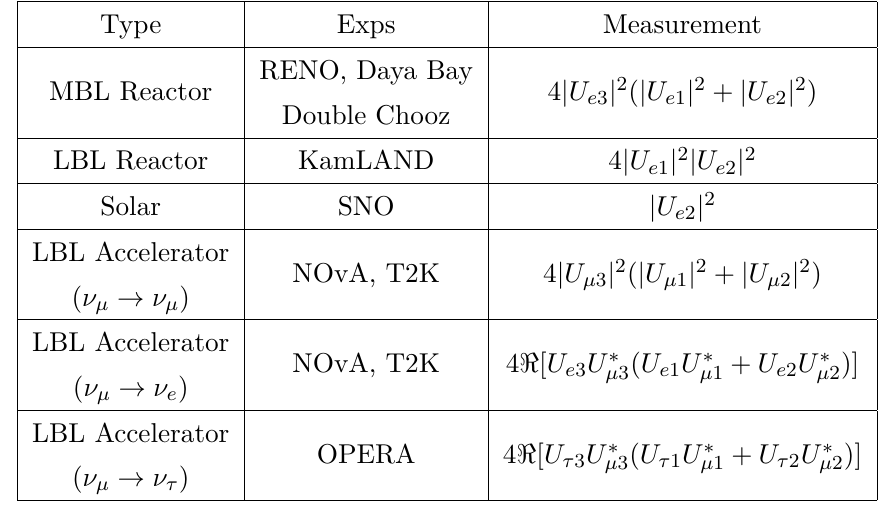
Table 1 . All relevant categories, experiments, and the corresponding measurements in this work. The abbreviations MBL and LBL denote medium and long baseline,